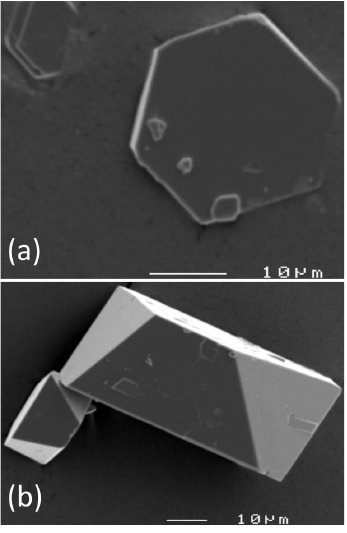
Figure 1 SEM micrographs of crystals of ( a ) RbFe(HAsO 4 ) 2 and ( b ) TlFe(- HAsO 4 ) 2